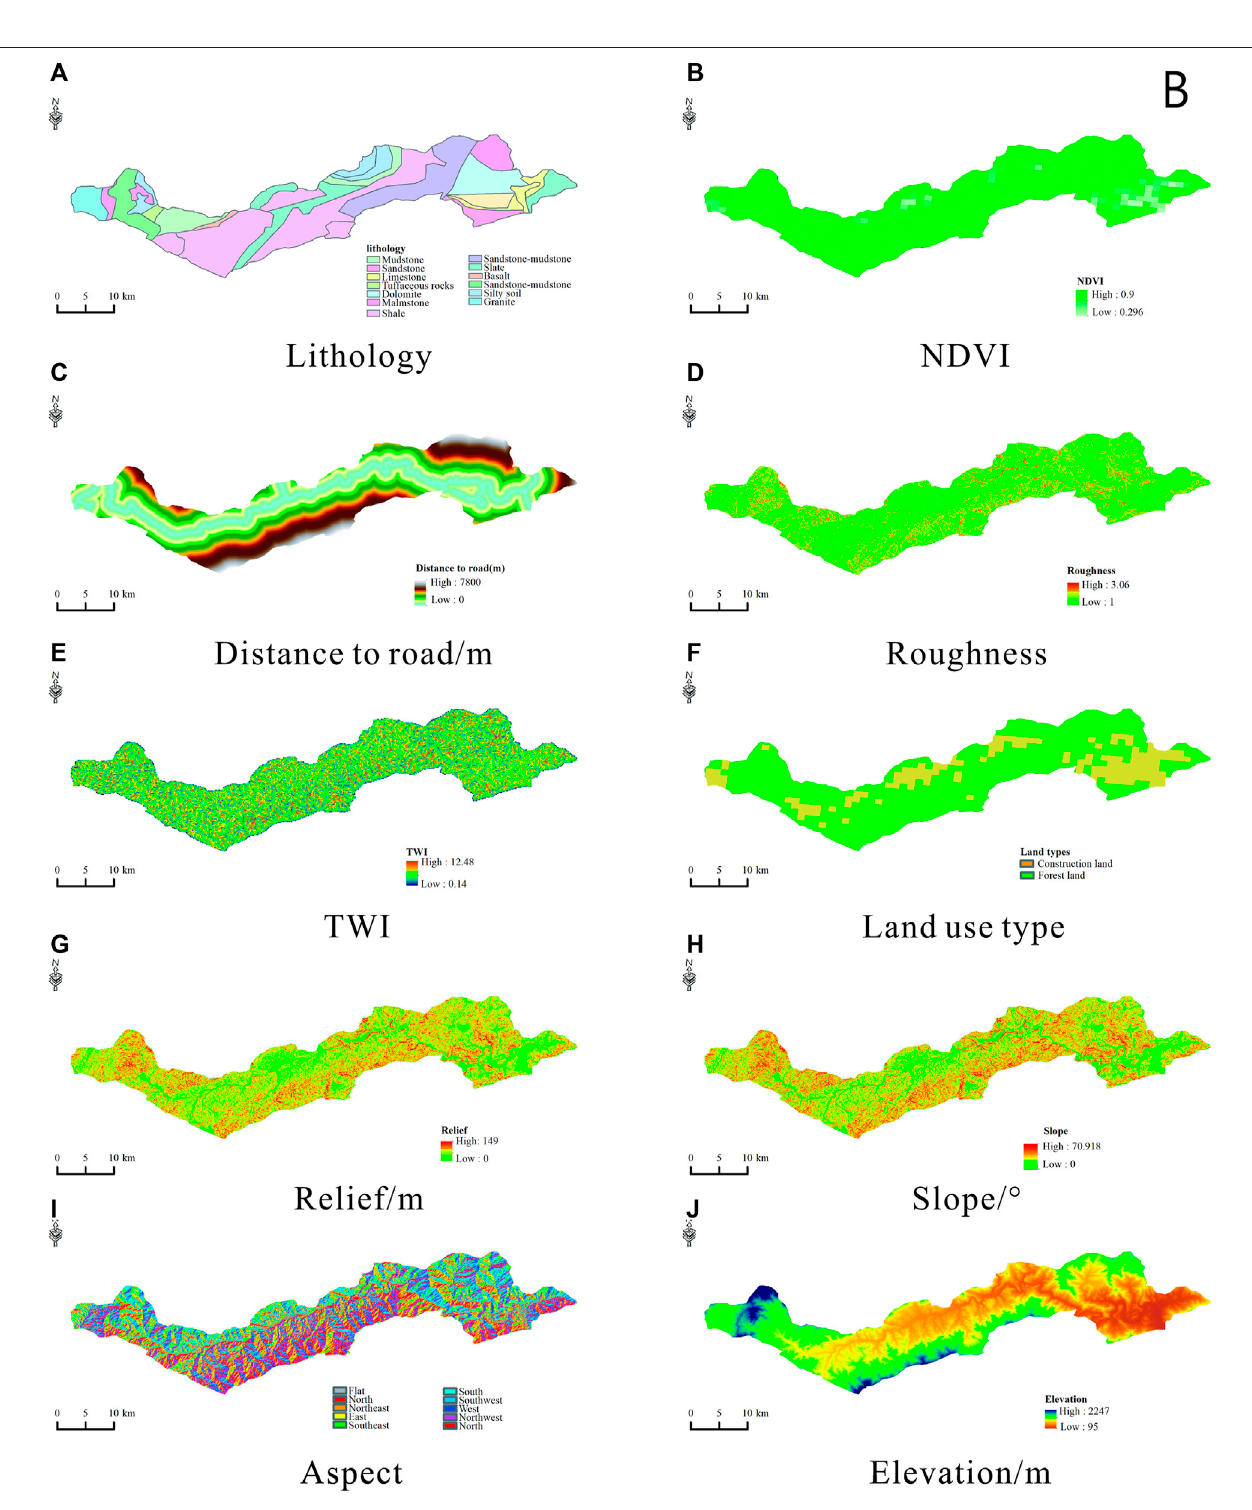
FIGURE2| Landslideconditionfactors. (A) Lithology, (B) NDVI, (C) distancetoroad, (D) roughness, (E) TWI, (F) landusetype, (G) relief, (H) slope, (I) aspectand (J) elevation.